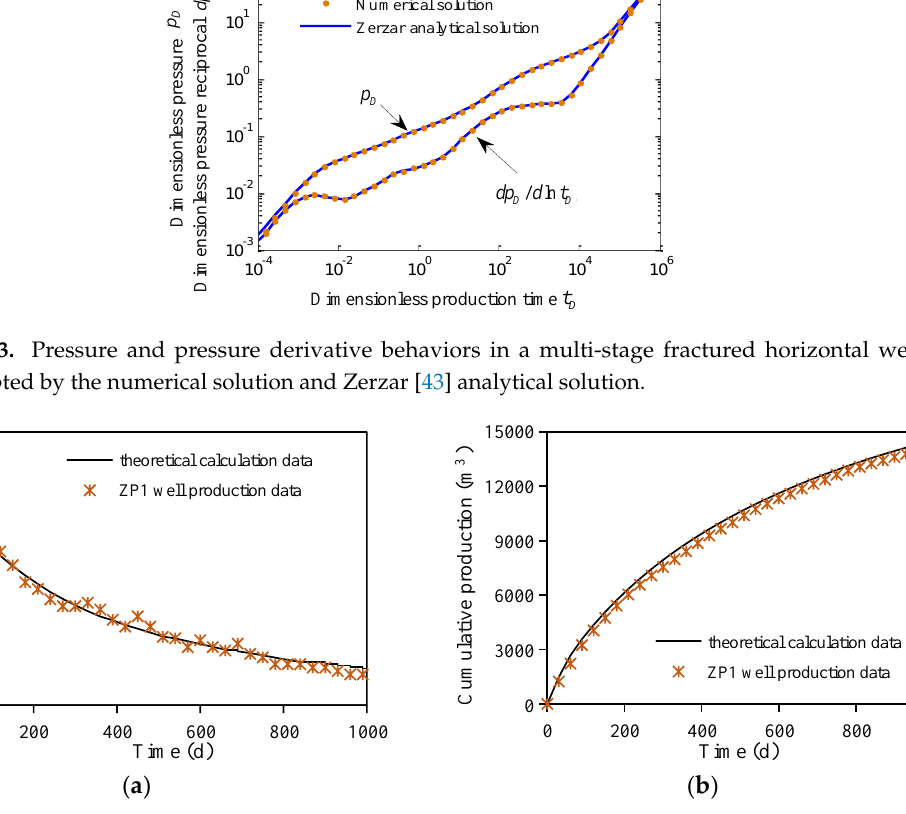
Figure 4. Comparison curve of the ZP1 well production data and theoretical calculation data. ( a ) Oil production rate. ( b ) Cumulative oil production.